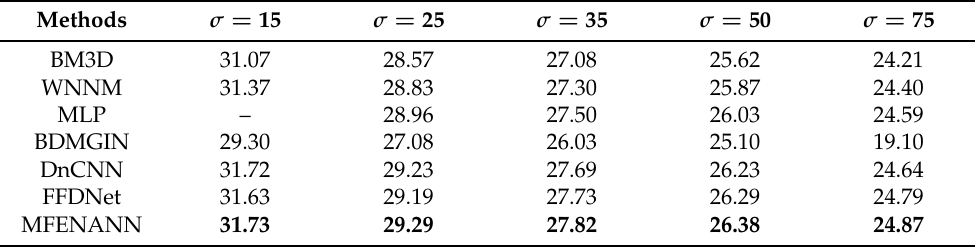
Table 6. Average PSNR (dB) for images in “BSD68” restored by several state-of-the-art methods at noise levels of 15, 25, 35, 50 and 75. The bold numbers are the largest ones at each corresponding noise